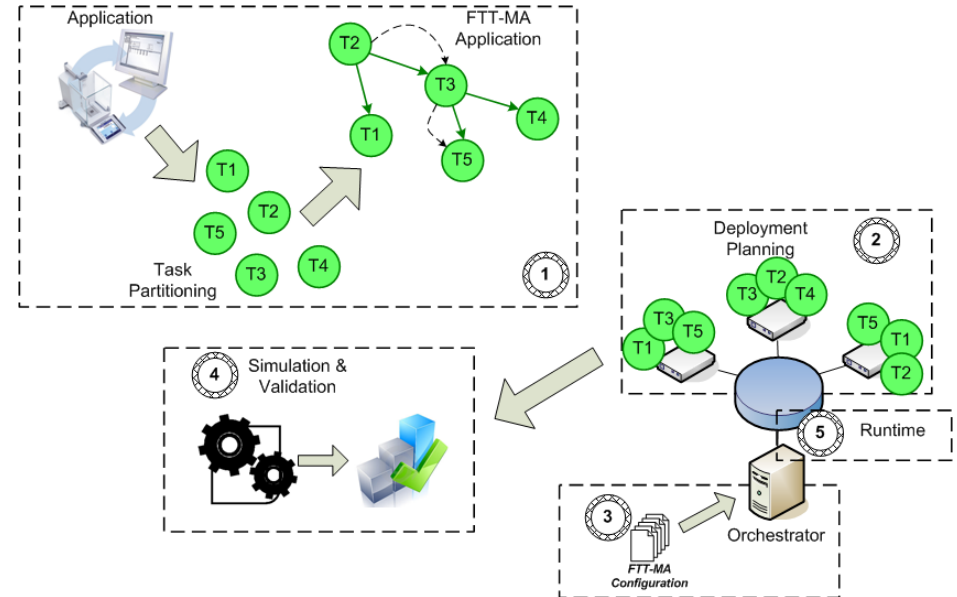
Figure 5. Methodology for application development and